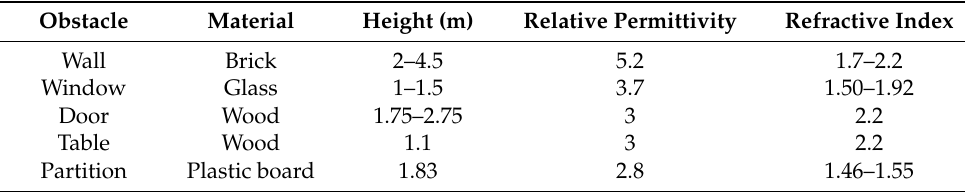
Table 3. Specifications of the experimental environment